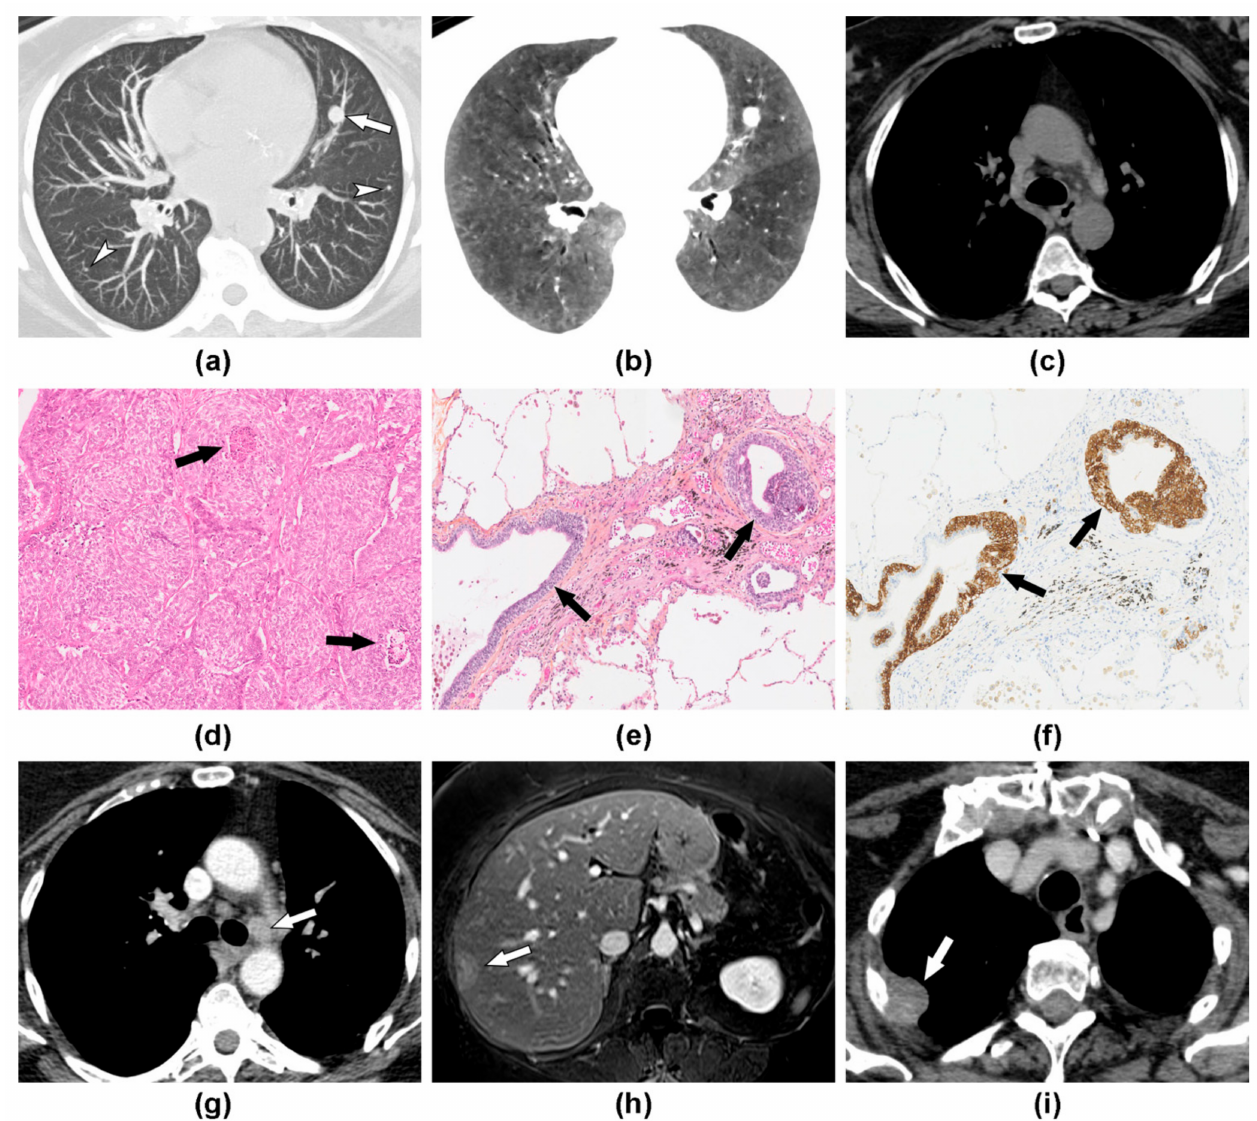
Figure 2. DIPNECH with metastatic course over an 8 year period in a 60-year-old woman. ( a ) Maximum intensity projection (MIP) reformation of baseline chest CT scan shows several nodules (arrow and arrowheads), including a 12 mm nodule in the left upper lobe (arrow). ( b ) Minimum intensity projection (MinIP) reformation reveals the characteristic association to diffuse mosaic perfusion. ( c ) There was no mediastinal lymph node enlargement. ( d ) Histopathological analysis of the 12 mm nodule shows carcinoid tumor with necrosis spots (arrows) consistent with an atypical form. ( e , f ) Analysis of distant parenchyma revealed bronchial cell proliferation (arrows) on hematoxylin and eosin stain (E), which corresponded to neuroendocrine cells hyperplasia on chromogranin A stain (F). ( g ) Five years later, contrast-enhanced CT shows the development of mediastinal lymphadenopathy leading to the new surgery. ( h ) Two years later, Gadolinium-enhanced T1 weighted axial image demonstrates liver metastasis leading to the start of chemotherapy. ( i ) Contrast-enhanced CT scan performed 6 months later shows disease progression with the occurrence of pleural metastasis (arrow). Nodal and liver metastasis were histologically confirmed and showed features of atypical lung